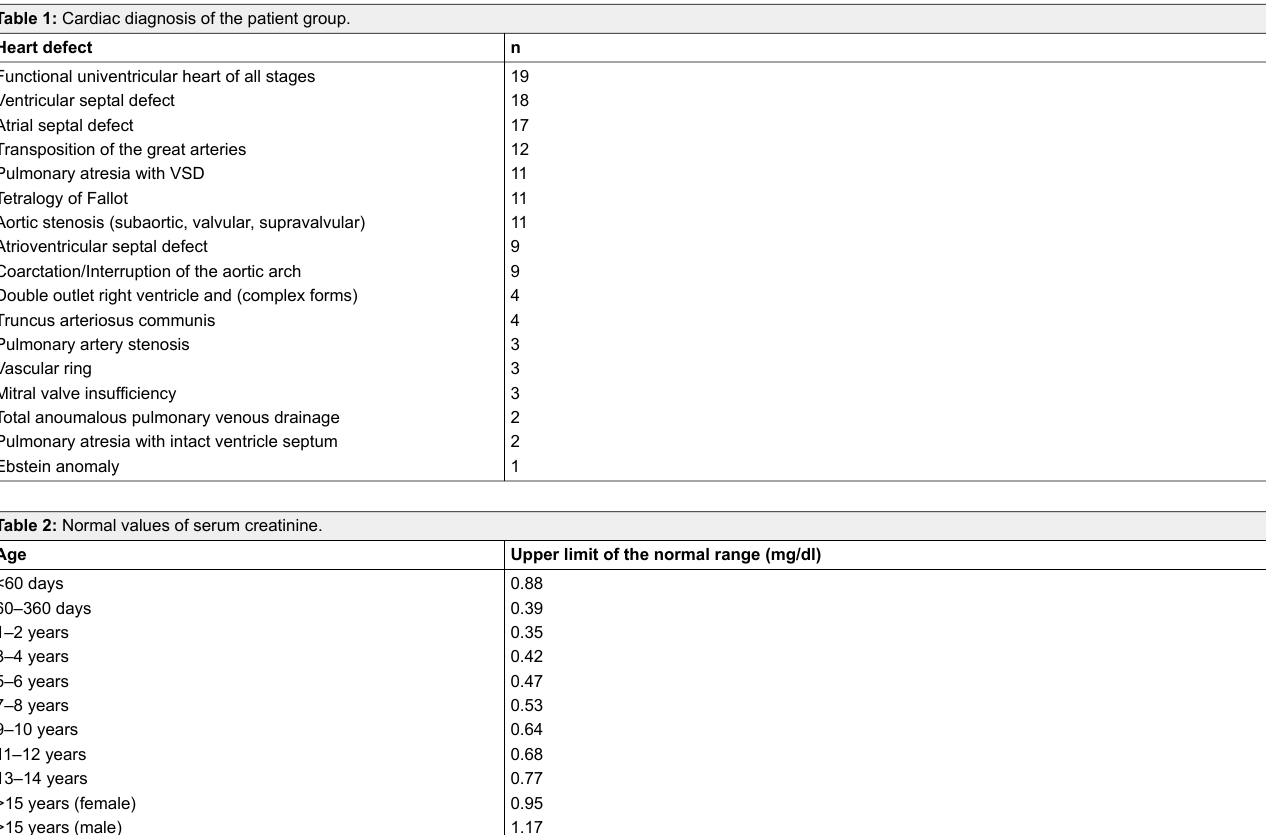
Kidney function